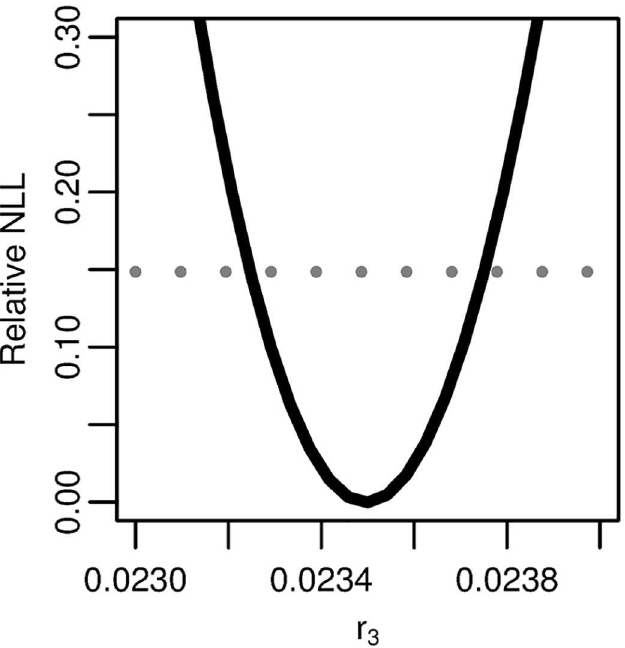
ffiffiffiffiffiffiffiffiffiffiffiffiffiffiffi p ¼ n X m = a is variedwhile the remaining 3 1